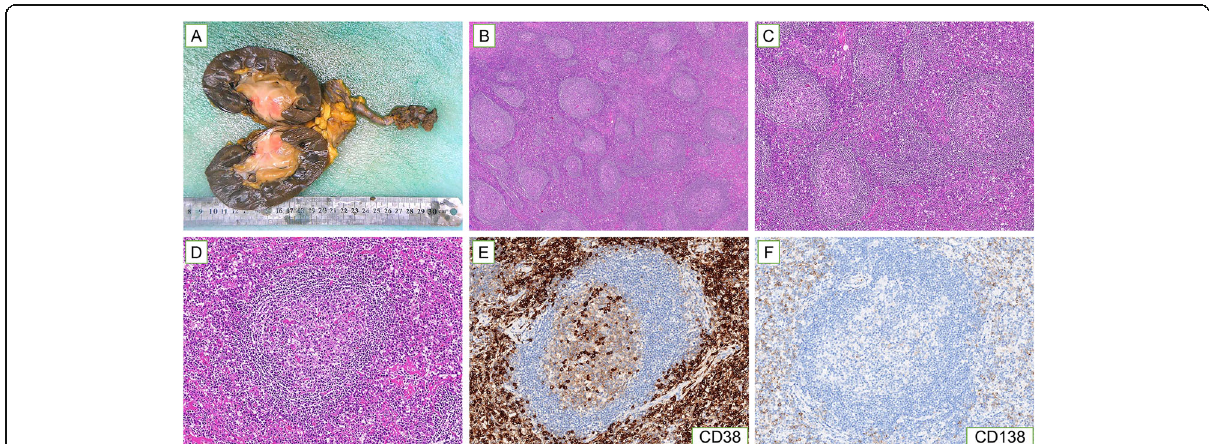
Fig. 2 Histopathologic features of the mass in case 1. (A) Gross observation of the mass in the right renal pelvis. (B) Abundant lymphoid tissue with lymphatic follicles in the specimen (40×). (C) Numerous plasma cells infiltrate the paracortex zone and lymphatic sinus (100×). (D) Eosinophilic deposits were observed in the follicle centers (200×). (E,F) Immunohistochemistry showed that the interfollicular area was infiltrated by CD38 (E) positive and CD138 (F) positive plasma cells